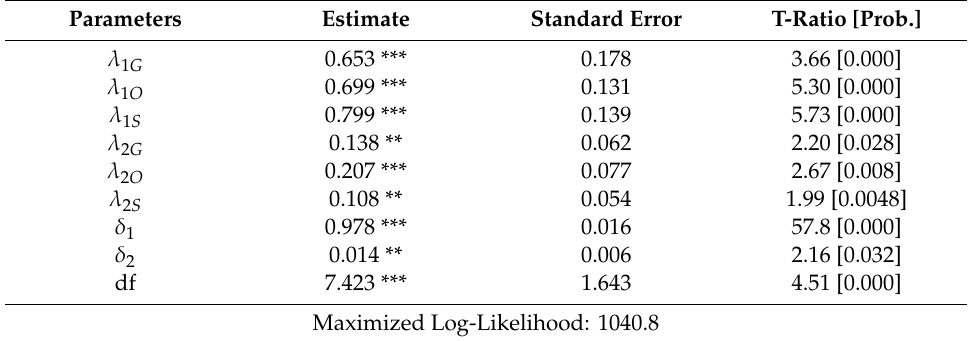
Table 3. Multivariate Garch (1,1)-Dynamic Conditional Correlation (DCC) Model. Sample: